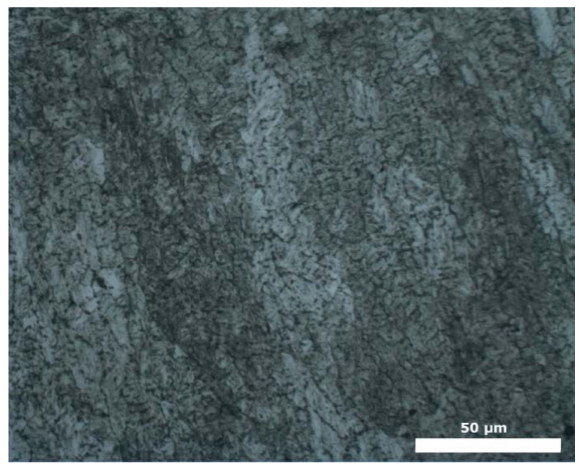
Figure 9. The microstructure of sample C.